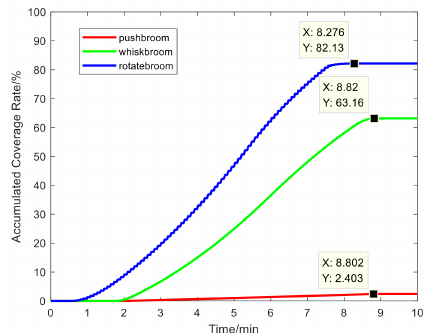
Figure 6. A diagram of the accumulated coverage